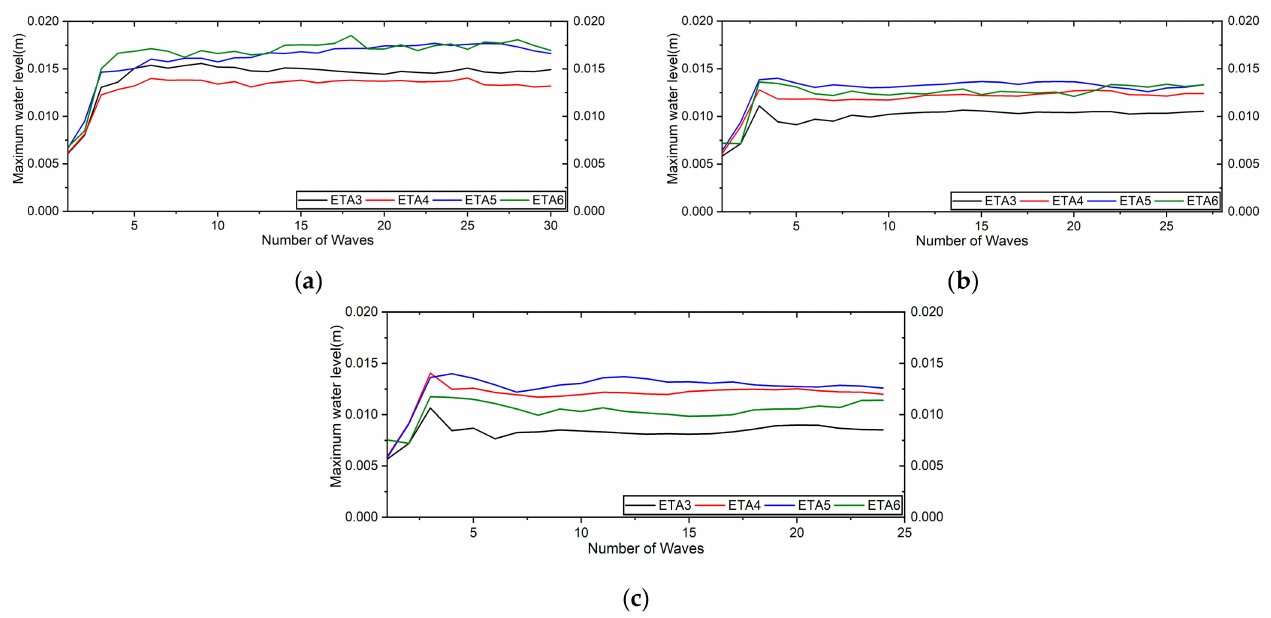
Figure 9. Variation in maximum water levels at W3 ( r = 300 cm ), W4 ( r = 336 cm), W5 ( r = 369 cm), and W6 ( r = 405 cm) for cross-section 1 of ( a ) case 1 (T-1.80 s), ( b ) case 2 (T-2.0 s), and ( c ) case 3 (T-2.25